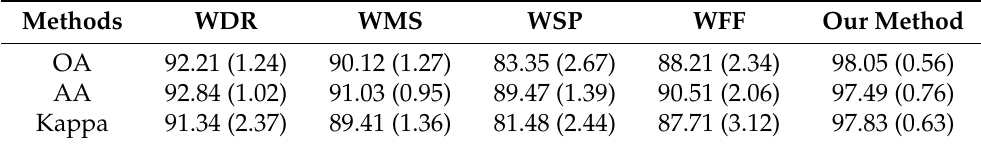
Figure 9. The influence of the number of scales C and the number of base superpixel T f . ( a ) The number of scales C . ( b ) The number of base superpixel T f . Table 4. Classification accuracies of the proposed method with or without several key